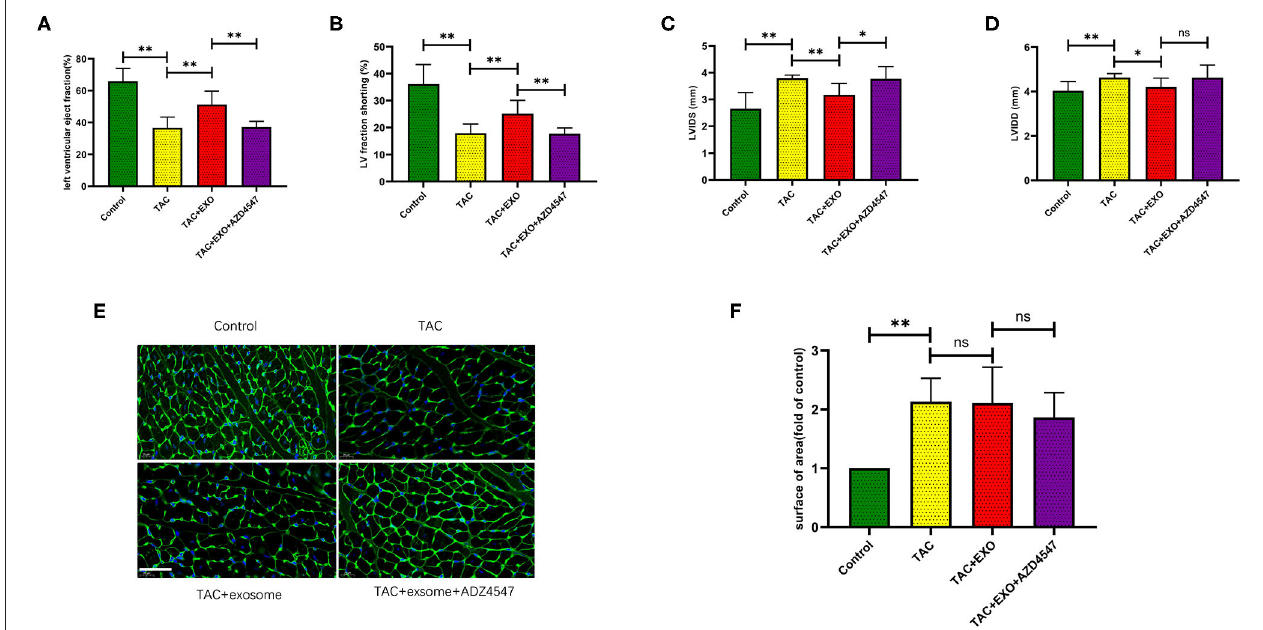
FIGURE 3 | ESCs-derived exosomes effectively rescued heart failure after TAC. (A–D) Exosomes treatment significantly rescued the heart function after TAC which was attenuated by AZD4547 administration. (E,F) TAC induced myocardium cell cross section area increasement significantly while exosomes treatment had no effect on cell size. ( n = 5—8, scale bar, 100 um). * p < 0.05, ** p <